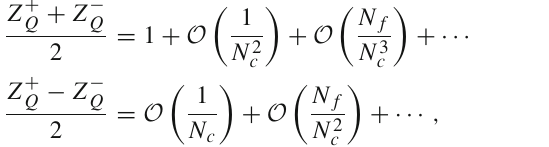
are independent of N c and N f . These relations imply that , N ) , but factorizable. On the Eq. (10) are of O ( N 2 f N c c